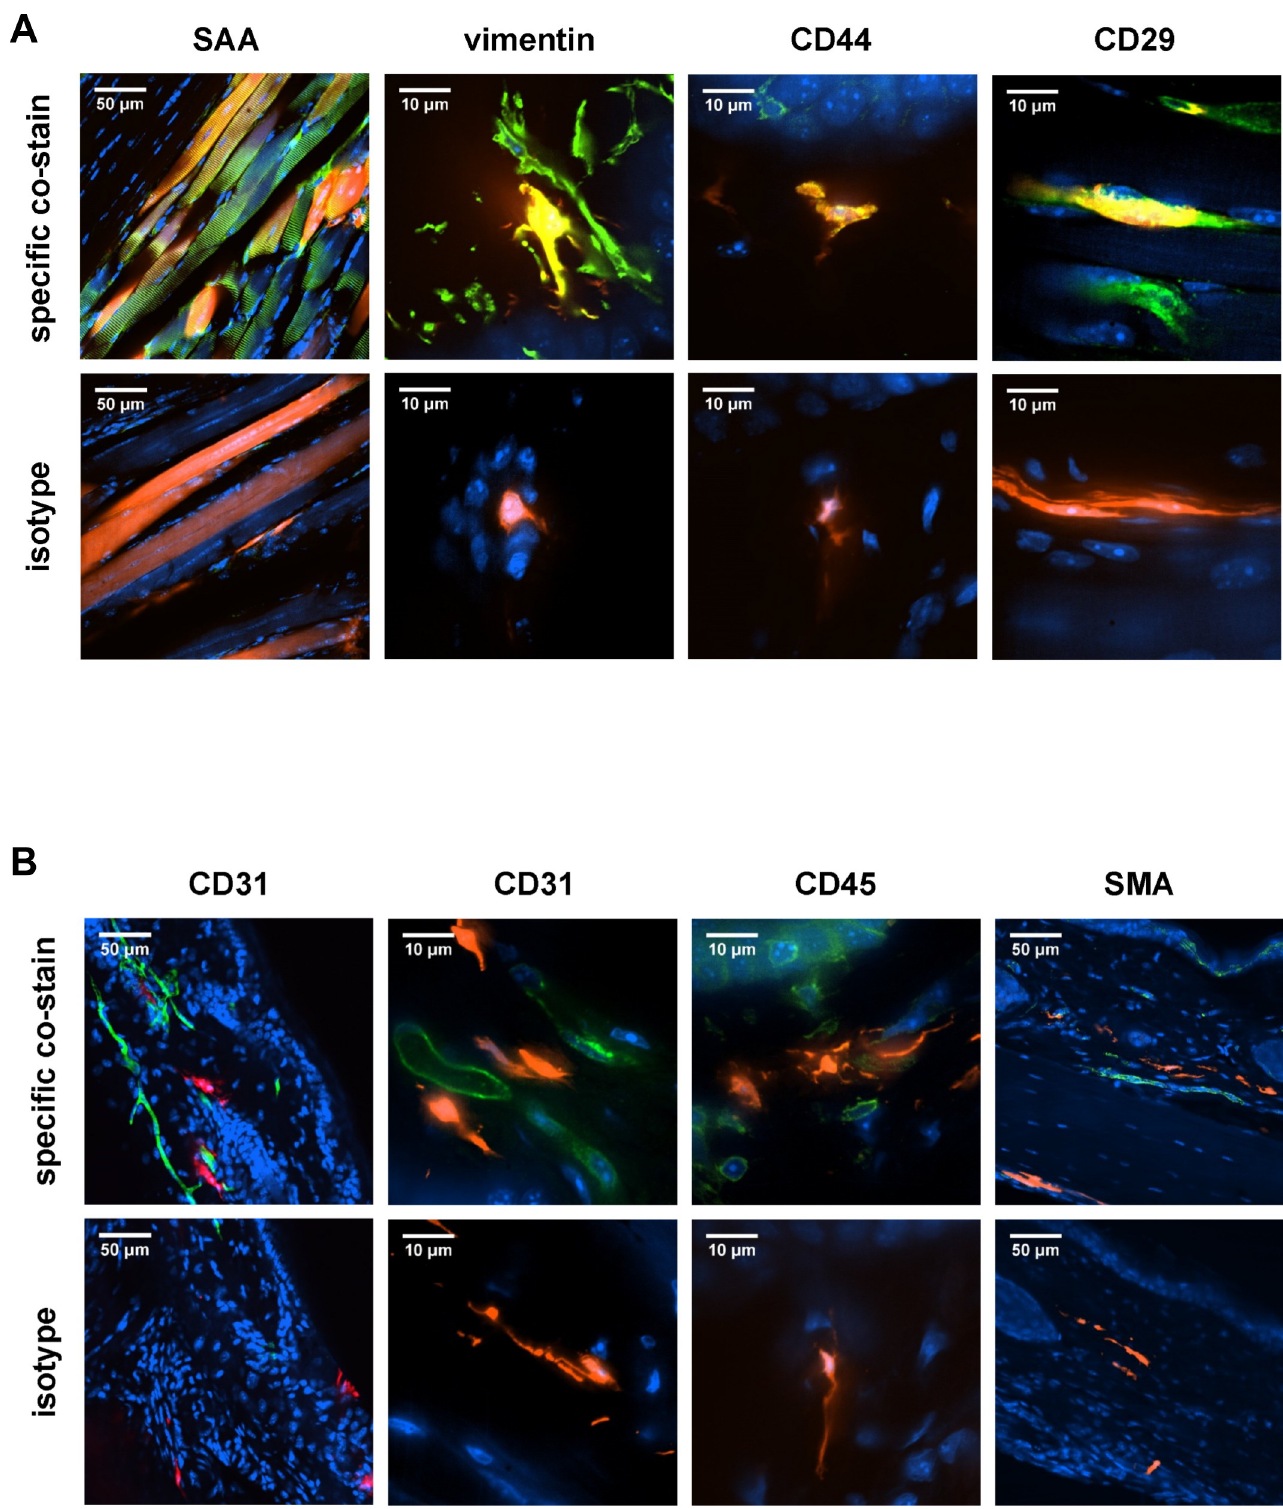
Fig 5. tdTomato + cells colocalize with markers for myofibers and fibroblasts. tdTomato mice were infected with 10 6 PFU CHIKV-3´-Cre (3´-Cre), and ipsilateral ankles were processed at 28 dpi. (A) Frozen sections were stained for markers of myofibers (SAA) or fibroblasts (vimentin, CD44, or CD29), with the corresponding isotype control shown below each co-stain. (B) Frozen sections were stained for endothelial cell (CD31), hematopoietic cell (CD45), or smooth